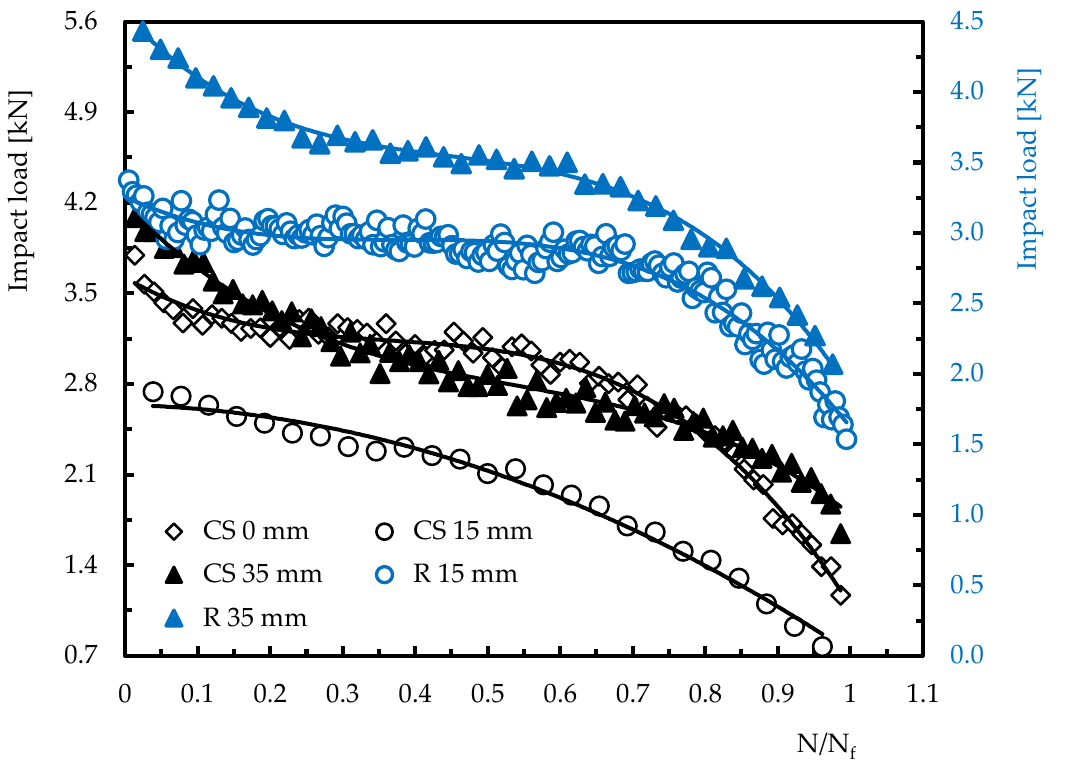
Figure 5. Impact load versus number of impacts for different geometries and distances.